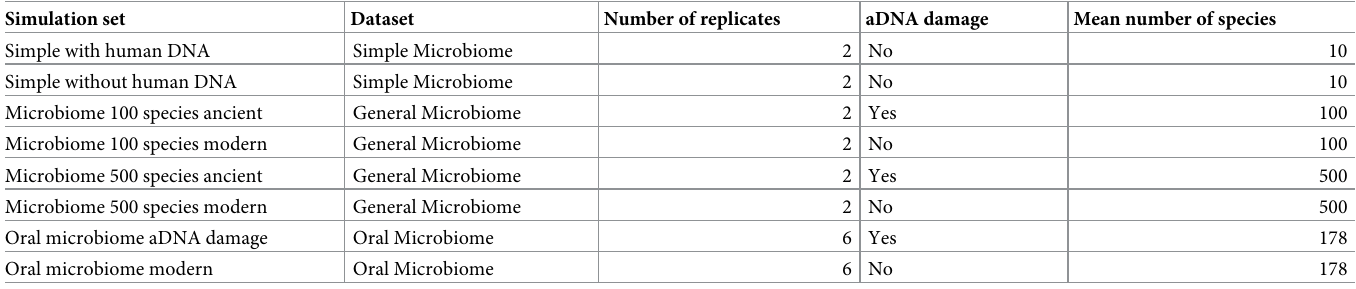
Table 1. Characteristics of the six simulated samples sets of the Simple, Random and Oral microbiome datasets. Simulation